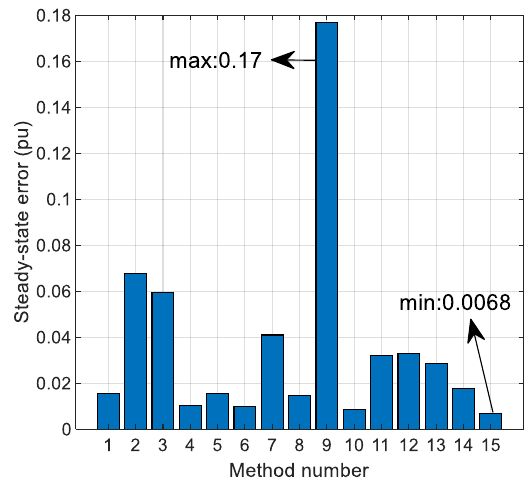
Figure 9. Steady-state error for each method from Table 3.